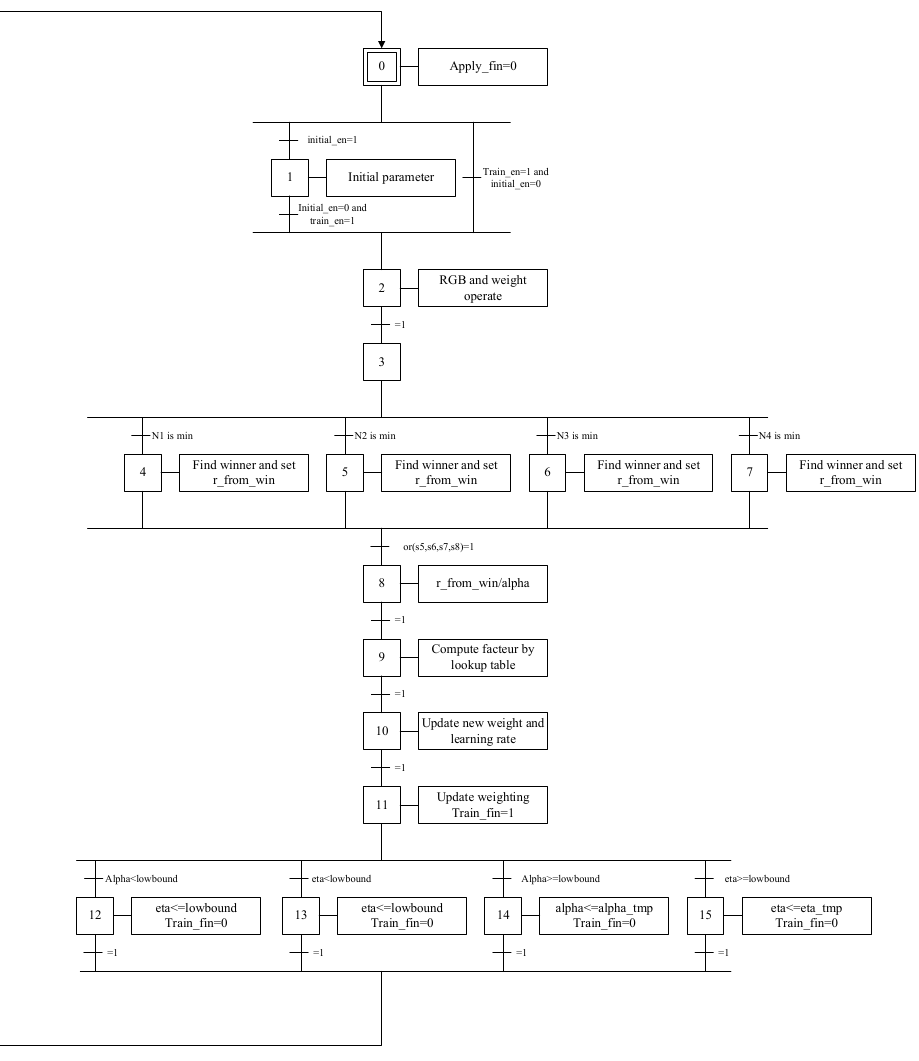
Figure 7. Grafcet discrete-event model of the SOM training module.